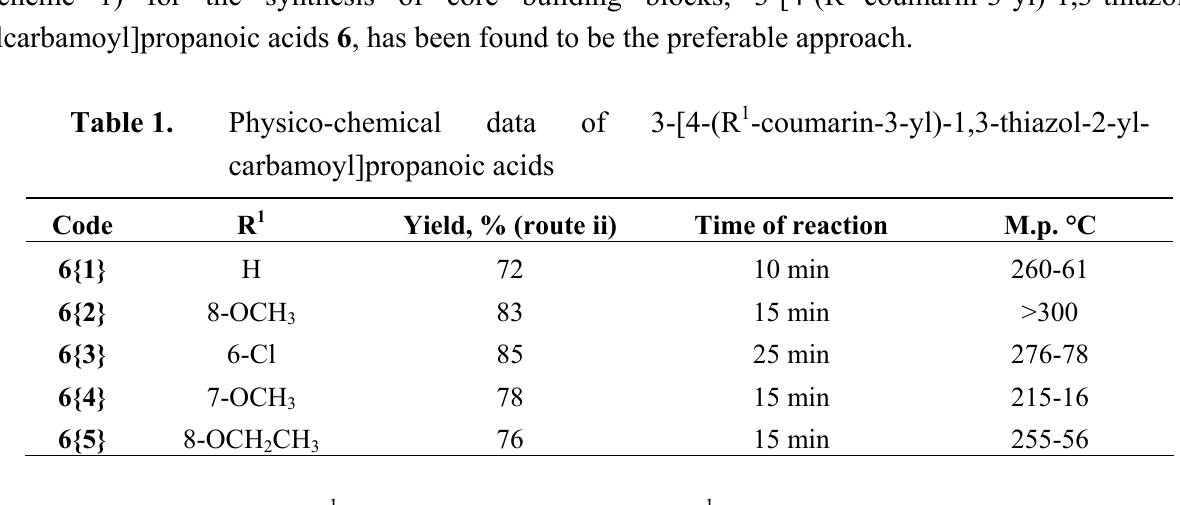
Table 2. IR and 1 H-NMR spectra of 3-[4-(R 1